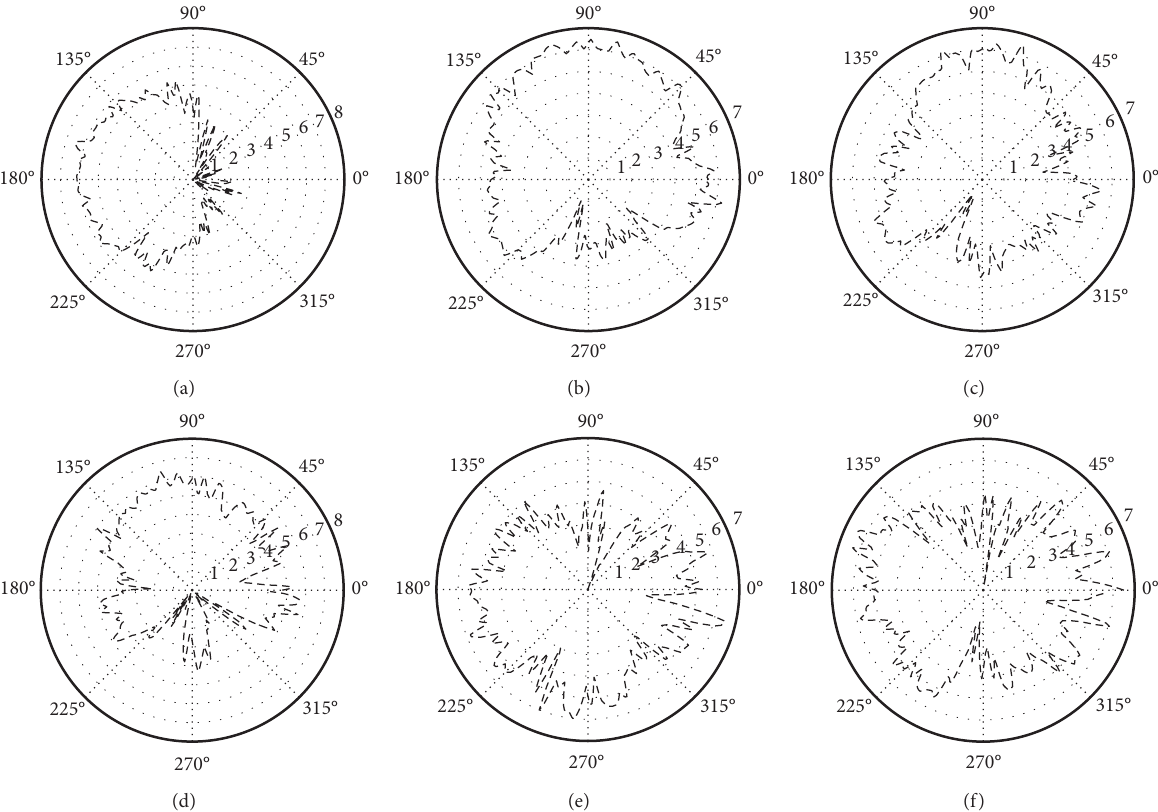
Figure 8: Elevation view of the radiation pattern: (a) 2.3GHz, (b) 2.4GHz, (c) 2.6GHz, (d) 3.5GHz, (e) 5.2GHz, and (f) 5.8 ISM2400 bands where the S11 is 4 dB lower than the results magnitude for frequencies higher than 5 GHz with an av- obtained at a separation of 1 m. The measurements confirm erage increase of the S11 up to − 8 dB compared to results that the target bands are covered in all the configurations obtained with 1 mm separation. For the frequencies lower and for both separation 1 and 0 mm. than 5 GHz, the results are slightly better for LTE2600 and